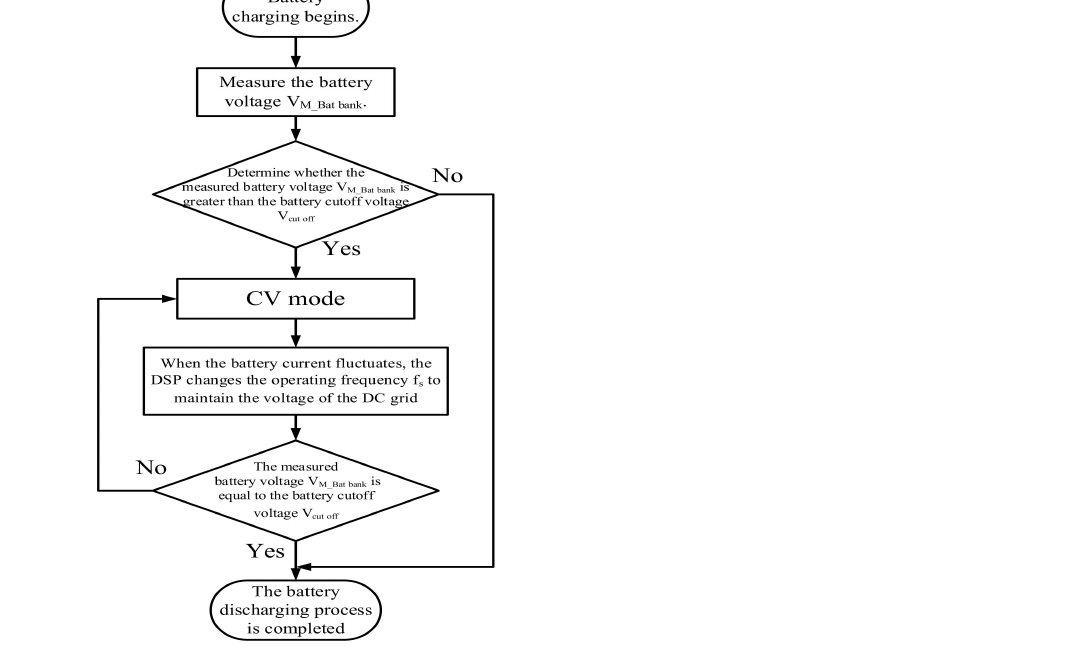
Figure 15. Flowchart of the proposed method for battery energy storage system discharging to a DC grid.